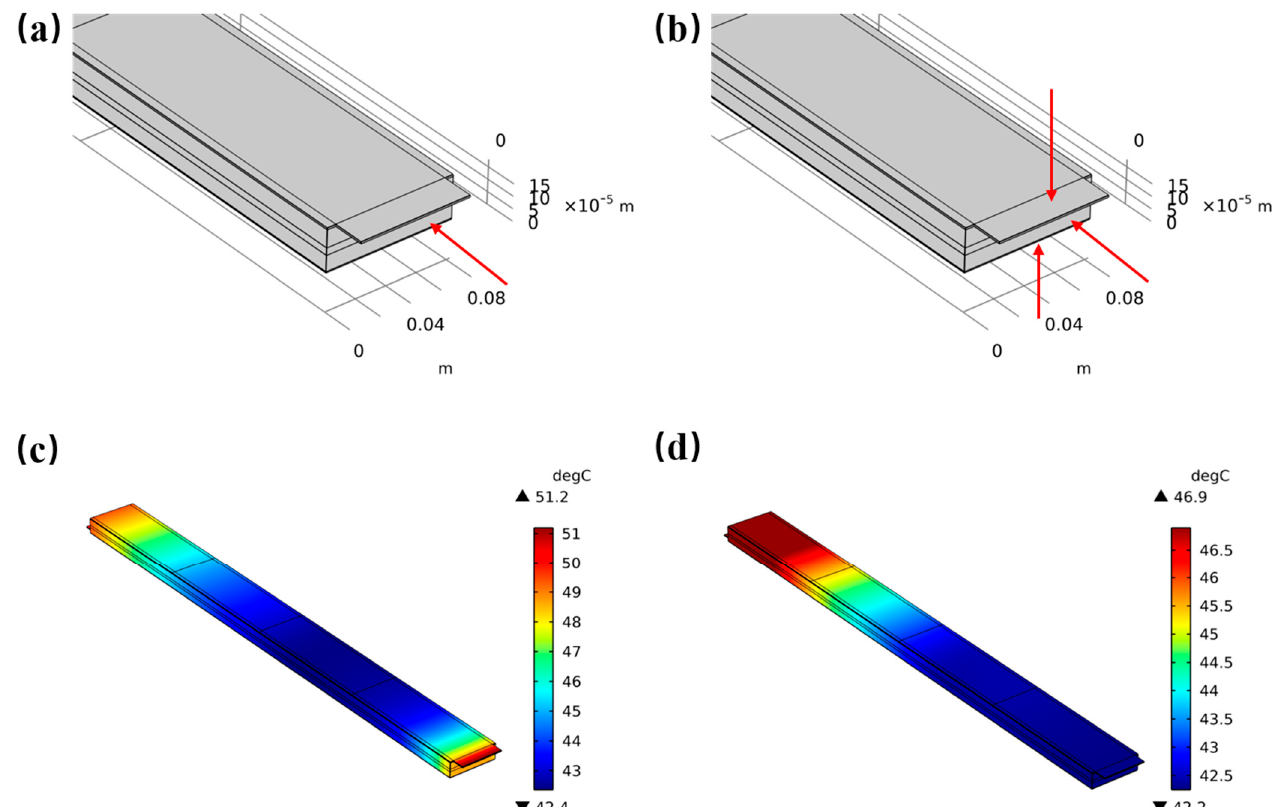
Figure 11. Scheme of increasing the pole-ear contact area. ( a , c ) Original scheme and its temperature distribution; ( b , d ) increasing the lug contact area and its temperature distribution.